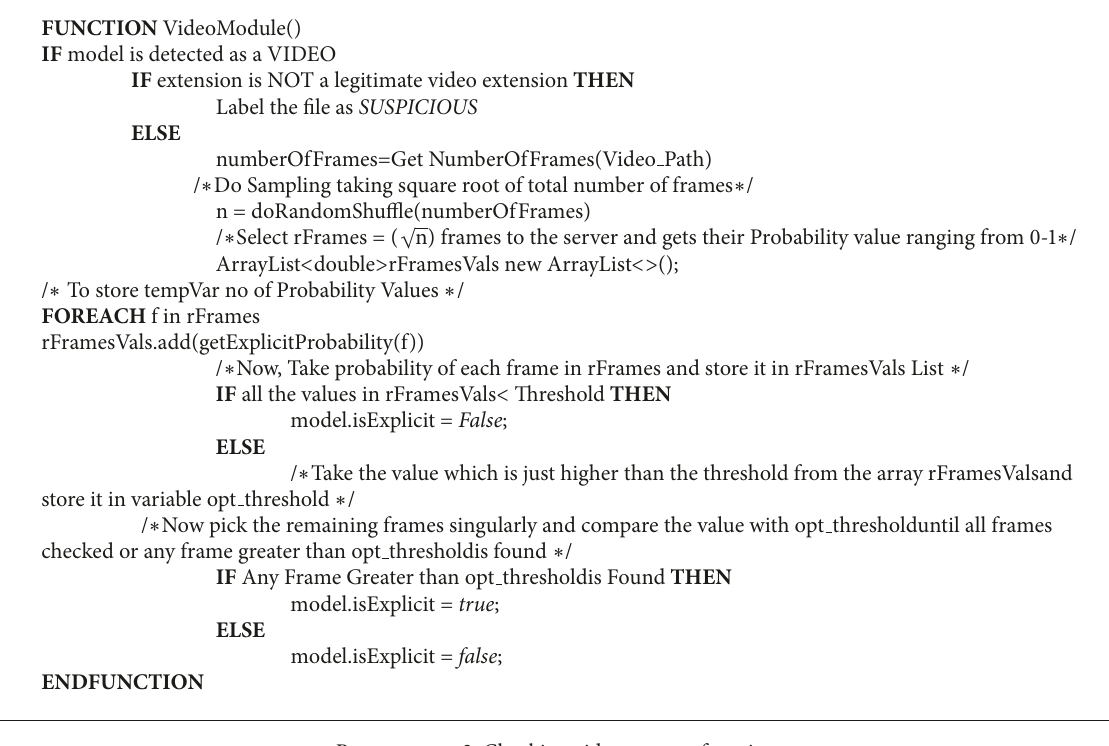
Pseudocode 2: Checking video content